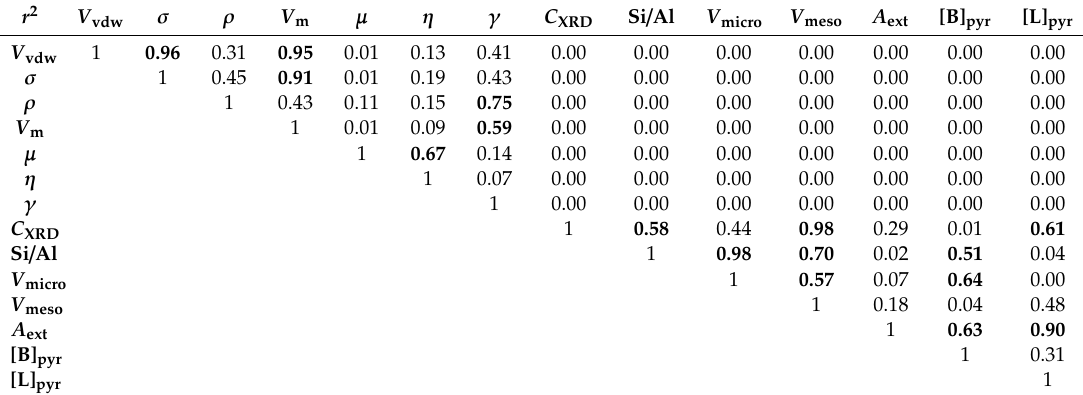
Table 6. Descriptors’ correlation matrix for the 14 descriptors